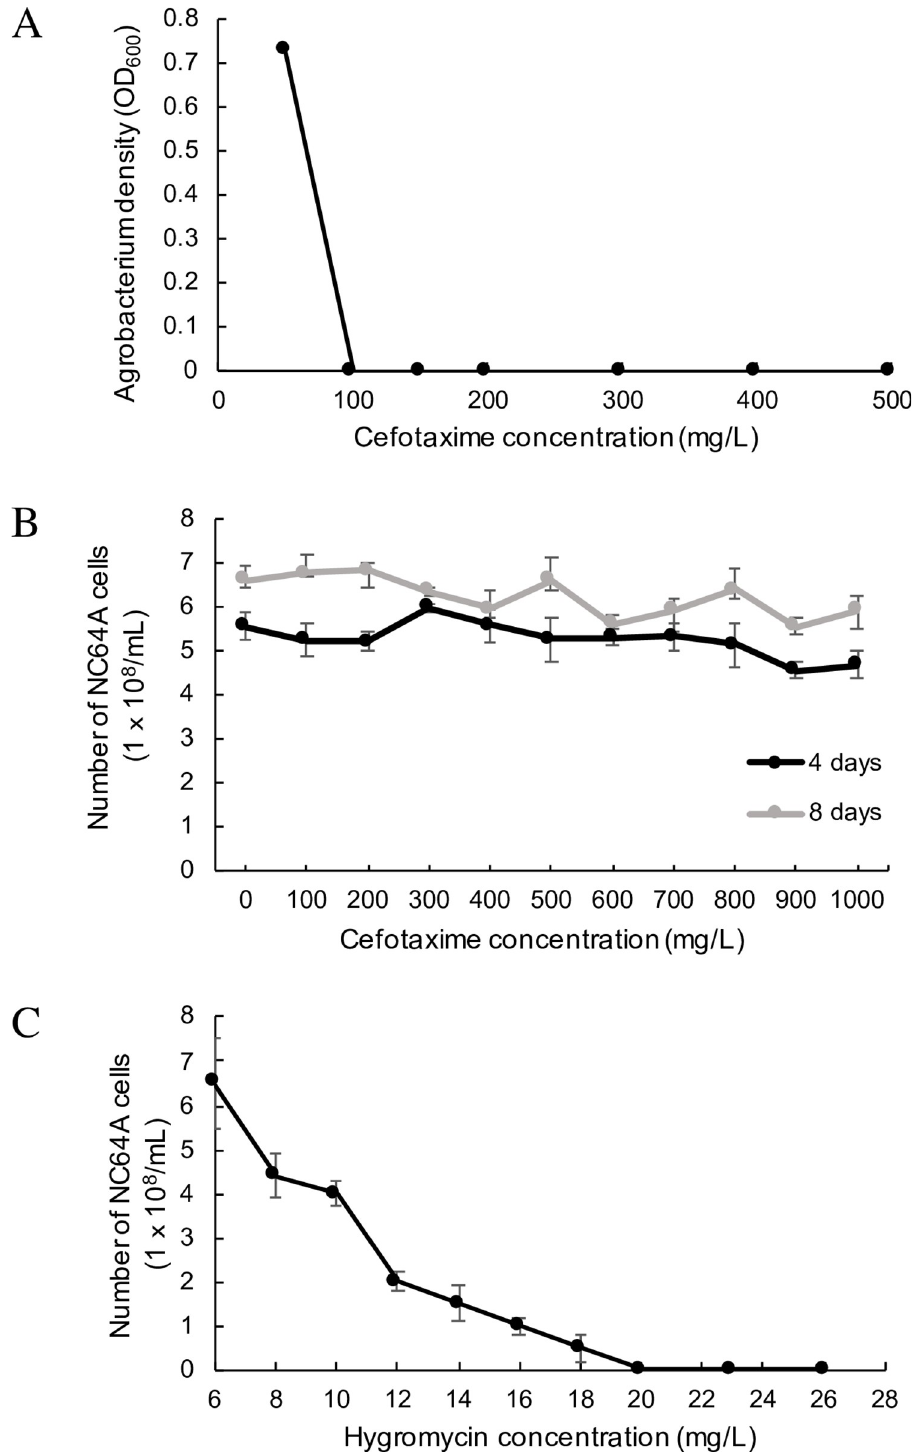
Fig 1. The effects of antibiotics on Agrobacterium and NC64A. (A) The effect of cefotaxime on Agrobacterium viability. The effects of (B) cefotaxime and (C) hygromycin on NC64A viability.